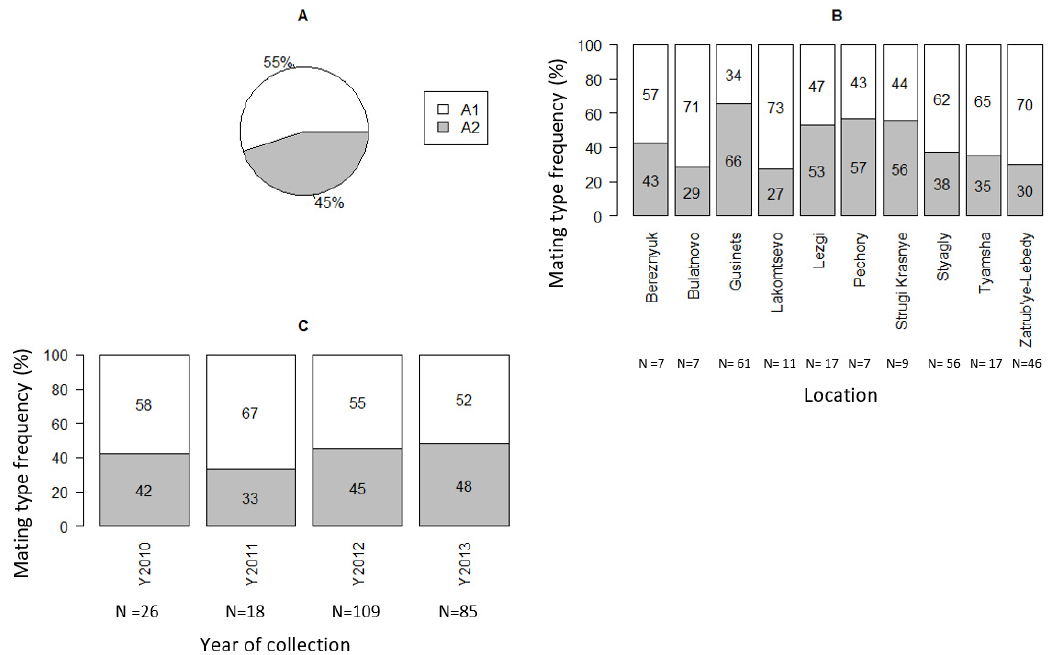
Figure 2. Mating types (A1, A2) frequency among P. infestans isolates collected from Pskov region in north-west Russia during 2010–2013. ( A ) For all isolates. ( B ) For locations. ( C ) For sampling years.